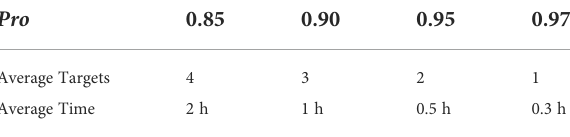
TABLE 2 Results under different Pro thresholds for selecting target points. Abbreviations: h : hour. Pro : the threshold of reliable candidate target